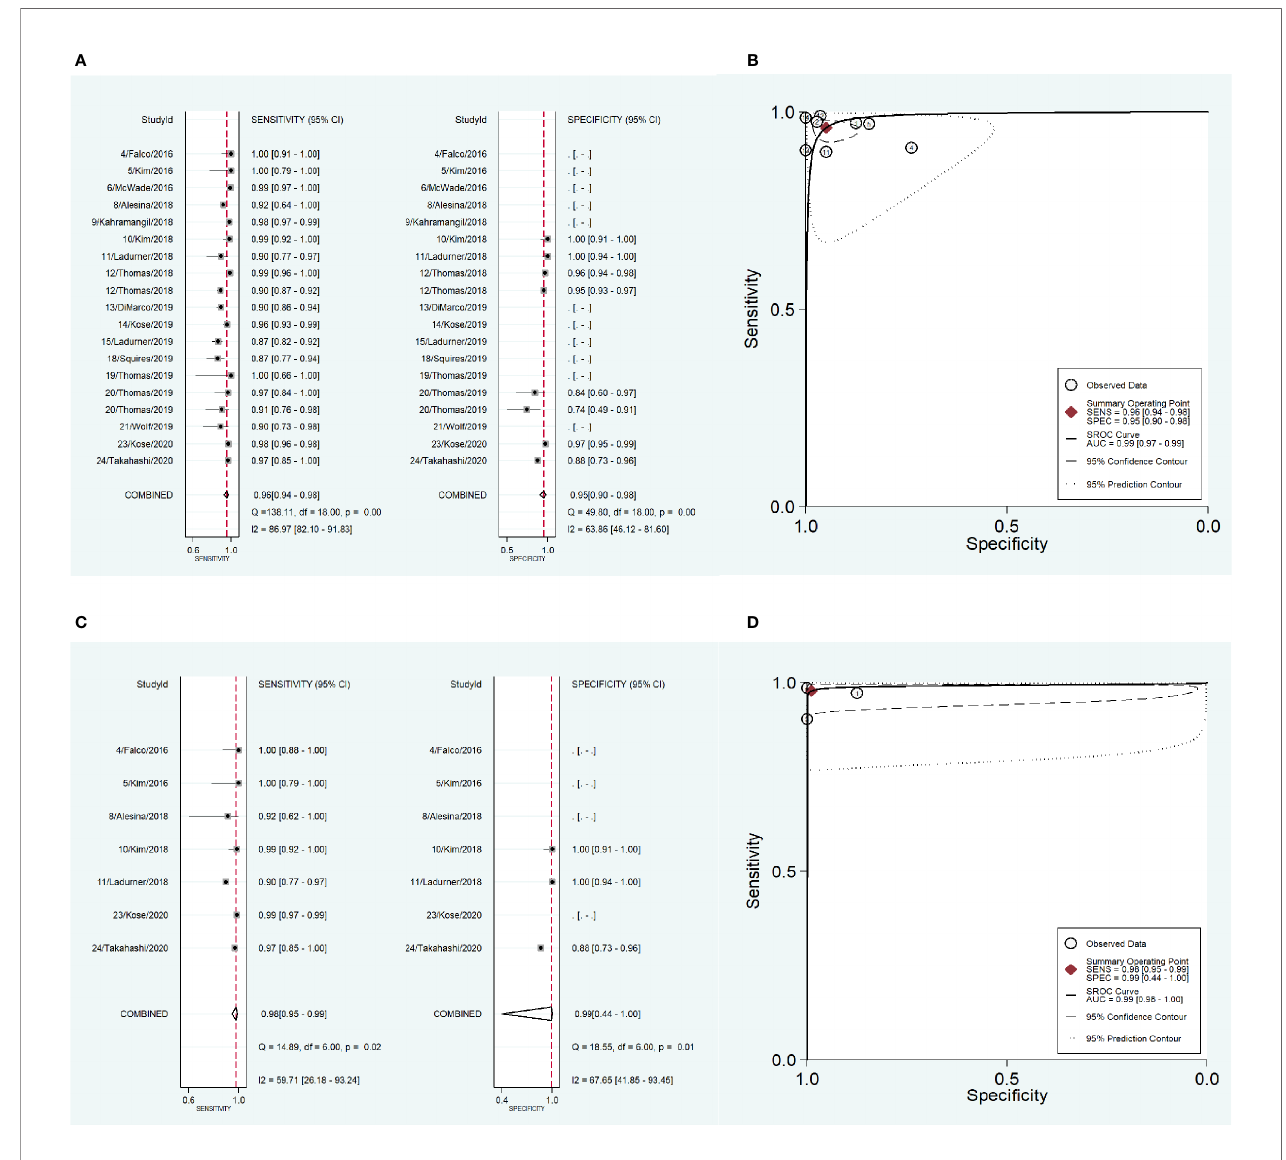
FIGURE 5 | The accuracy of near infrared auto fl uorescence in the subgroup analysis of the type of disease. (A) forest plot of the studies in the subgroup of primary hyperparathyroidism and thyroid disease. (B) summary receiver operating characteristic (SROC) curve in the subgroup of primary hyperparathyroidism and thyroid disease. (C) forest plot of the studies in the subgroup of thyroid disease. (D) summary receiver operating characteristic (SROC) curve in the subgroup of thyroid